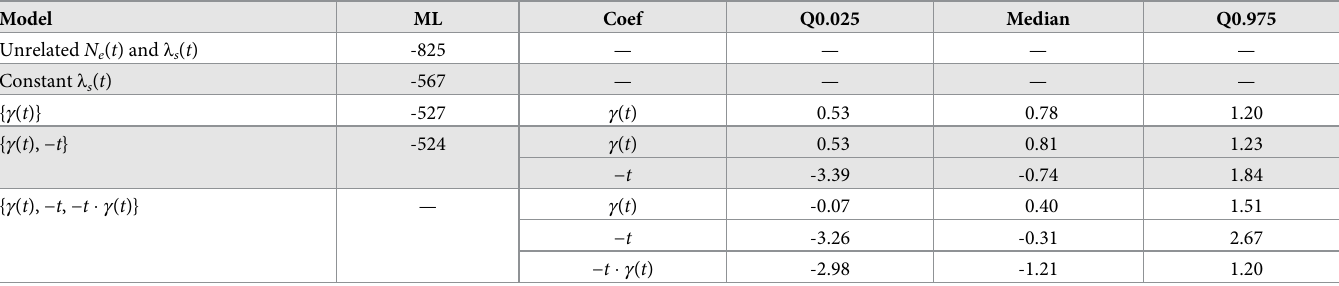
Table 5. Summary of Liberia Ebola sequence data inference. Posterior distribution quantile summaries for BEAST implementation of BNPR-PS models: with no covari- ates (model: { γ ( t )}), with an ordinary covariate (model: { γ ( t ), − t }), with both an ordinary and interaction covariate (model: { γ ( t ), − t , − t � γ ( t )}). Using a fixed tree, we also include marginal likelihoods (MLs) for all of the above models with no interactions, plus a model with N (Unrelated N e ( t ) and λ s ( t )) and a conditional model combined with a constant sampling intensity model for sampling times (Constant λ s ( t )).